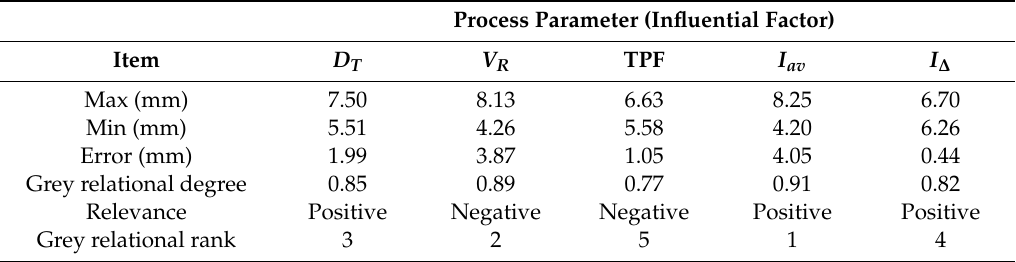
Figure 5. The normalized results of various process parameters and bead width after linear transformation for special parameters. Table 5. Grey relational analysis about the bead width B.